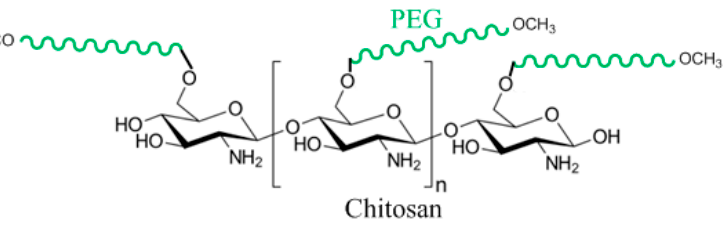
/ PEG-Chitosan nanoparticle